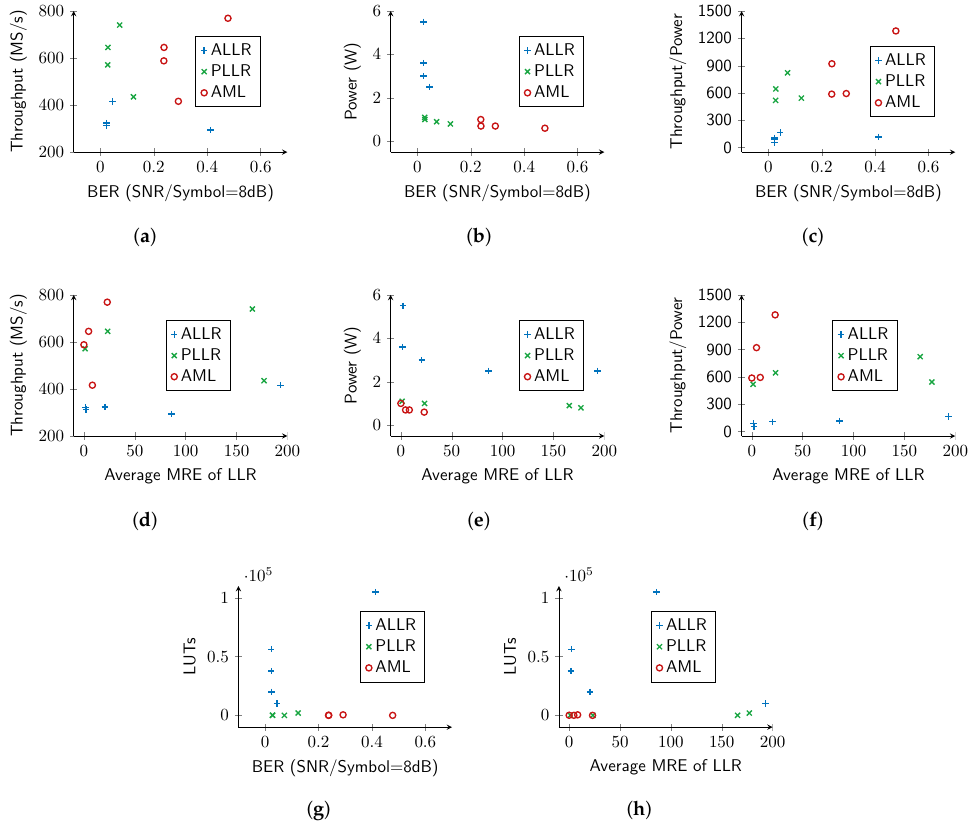
Figure 7. Pareto analysis of the proposed 64-QAM circuits in terms of accuracy and hardware resources. ( a ) BER–throughput. ( b ) BER–power. ( c ) BER–throughput/power. ( d ) MRE–throughput. ( e ) MRE–power. ( f ) MRE–throughput/power. ( g ) BER-LUT. ( h )